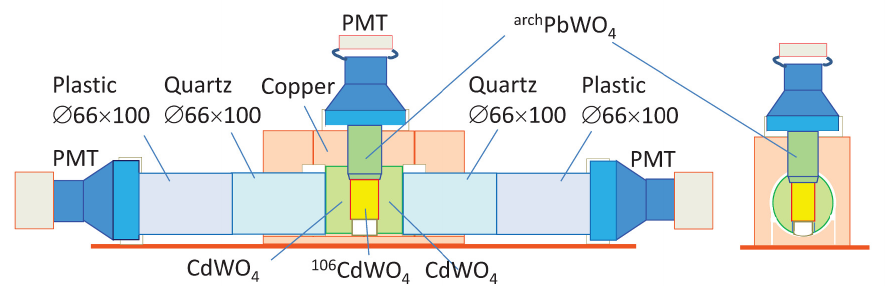
Figure 3. Schematic view of the 106 CdWO 4 setup that is now running in the DAMA/CRYS setup at